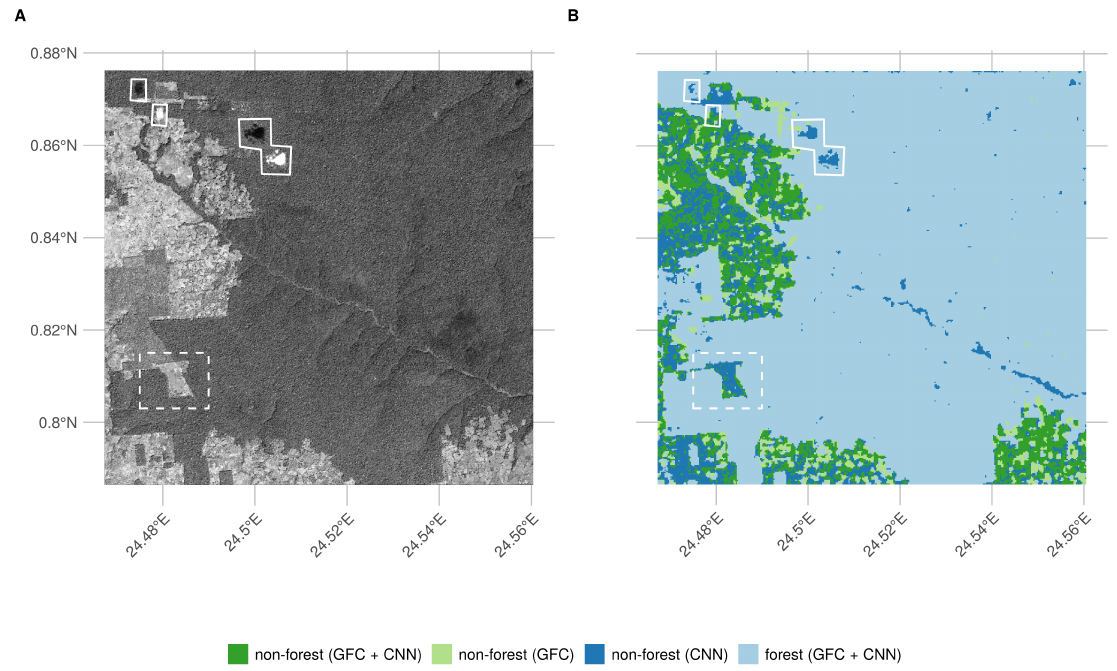
Figure 7. Convolutional Neural Network (CNN)-based forest cover classification results ( B ) as run on a recent (2011) Geo-Eye panchromatic image ( A ): We show the difference between the convolutional neural network-based classification and a recent Landsat-based forest cover map by Hansen et al. 2013. Full white outlines denote cloud contamination; the dashed rectangle shows a location where the CNN outperforms the Landsat based forest